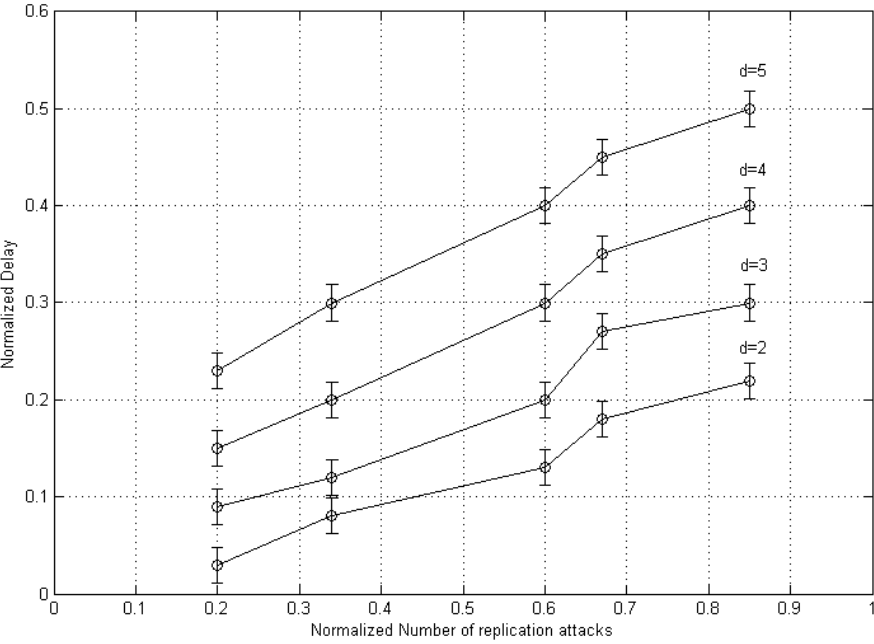
Figure 14. Delay effect of DT approach on detection